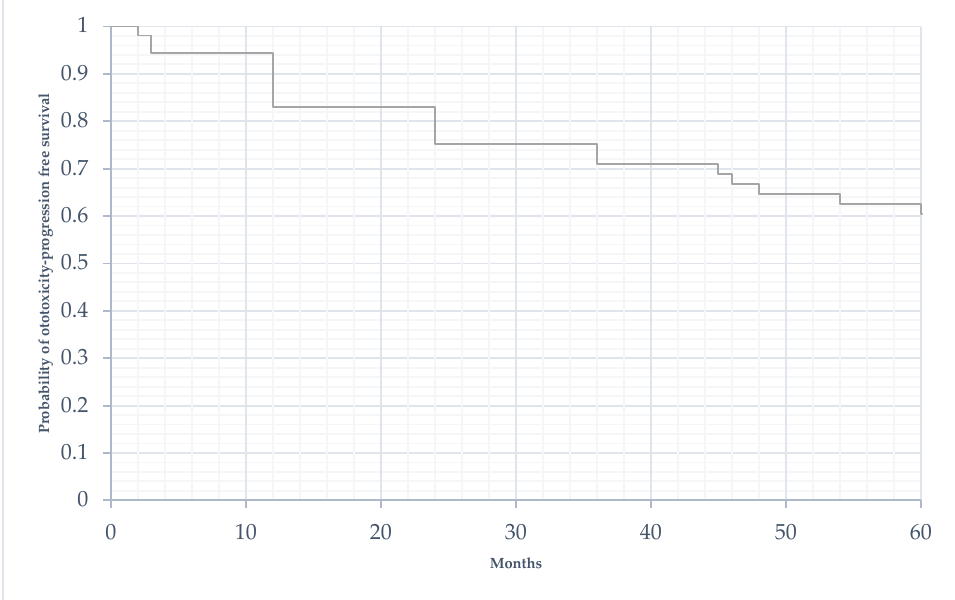
Figure 3. Time to progression of acoustic damage in the 5 years following the end of treatment (in months).